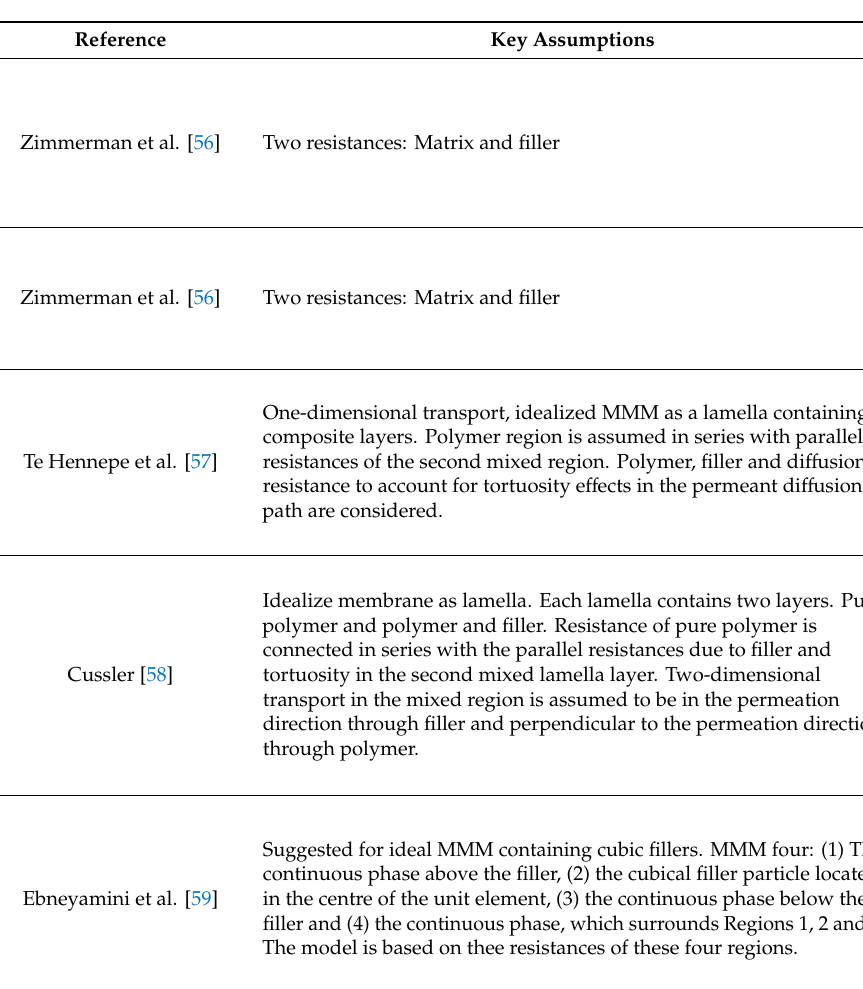
Table 1. Resistance-based models.